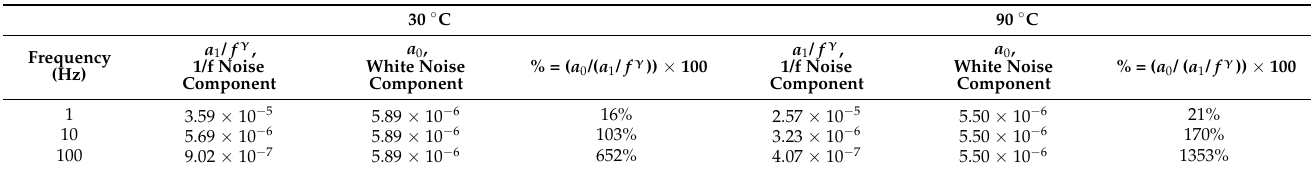
Table 2. Total average noise decomposition for tri-mPHMR sensors at two different temperatures. The sensing current was 1 mA (fit with Equation (14)).